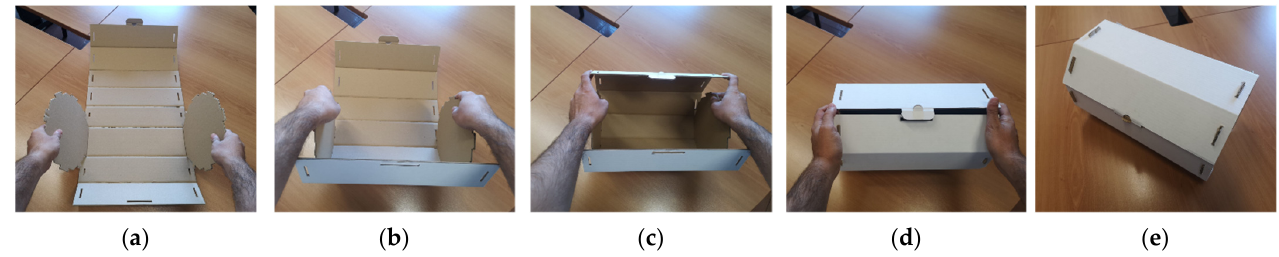
Figure 4. Some of the successive phases for packaging folding: ( a ) folding of the lateral octagonal faces, ( b ) roto-translation of the box to lock the flaps of the octagonal face with the windows of the rectangular faces, ( c ) folding by wrapping of the rectangular faces on the flaps of the octagonal faces (folding strategy alternative to ( b )), ( d ) closing of the final flap on the longitudinal dimension of the distal rectangular face, and ( e ) the final folded box.